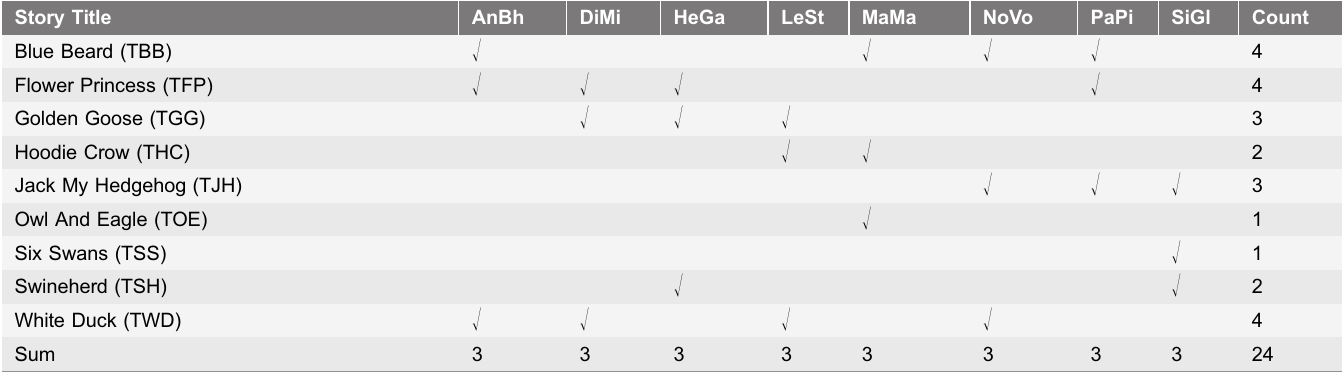
Table 3. Stories narrated by actors during motion capture